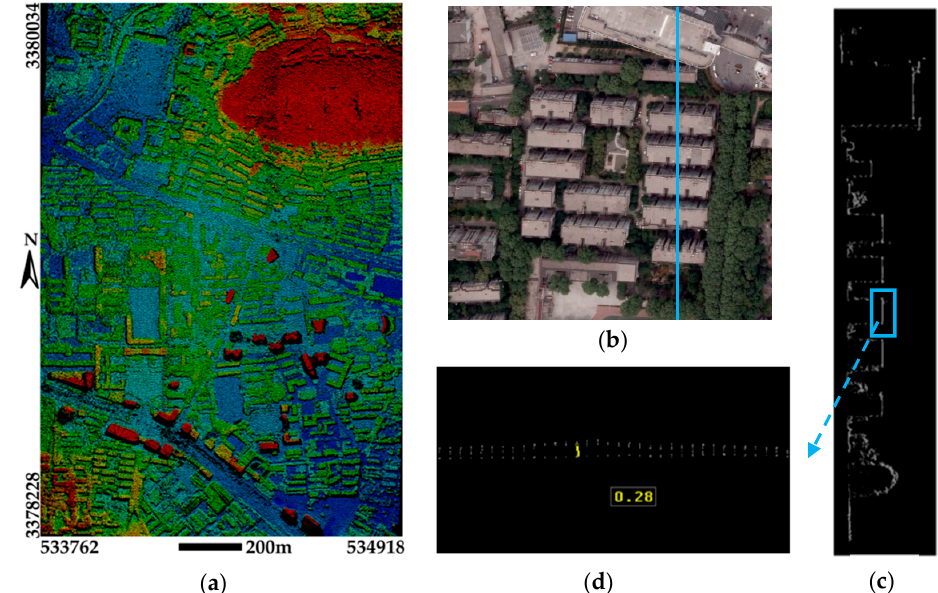
Figure 9. Photogrammetric point clouds and the co-registration result of a local area: ( a ) the photogrammetric point clouds; ( b ) a sub area for illustrating the point cloud profile; ( c ) two profiles from both source of point clouds; and ( d ) amplified view of cyan rectangle in ( c ).